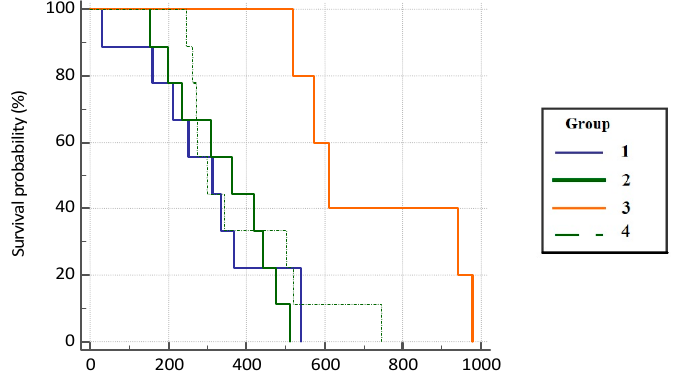
Figure 3. Overall survival probability (OS, %) in analyzed groups of patients. Table 2. Hazard ratios (HR) with 95% confidence interval for OS.